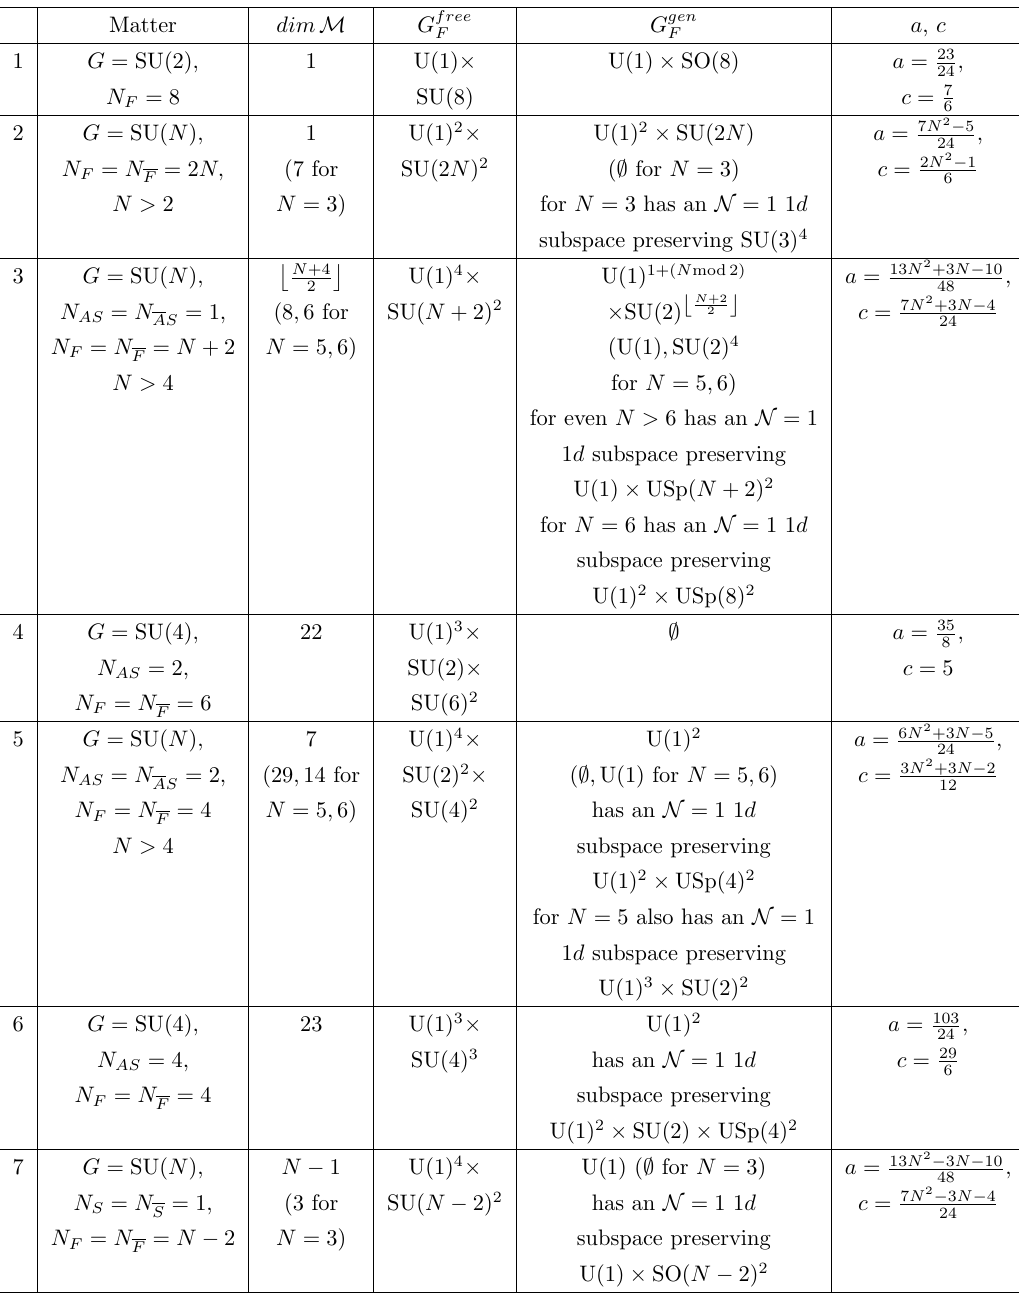
Table 25 . Cases involving an SU( N ) gauge group with extended supersymmetry. All cases also have an adjoint chiral (cid:12)eld in addition to the matter written in the